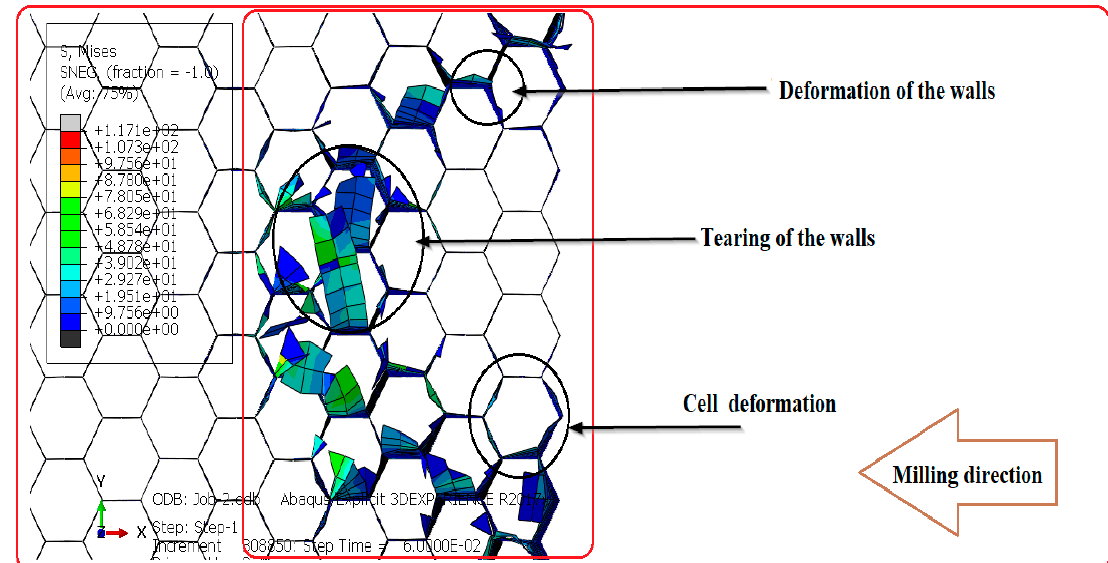
Figure 18. Resulting machined surface quality by the cutting blade of 18.3 mm.